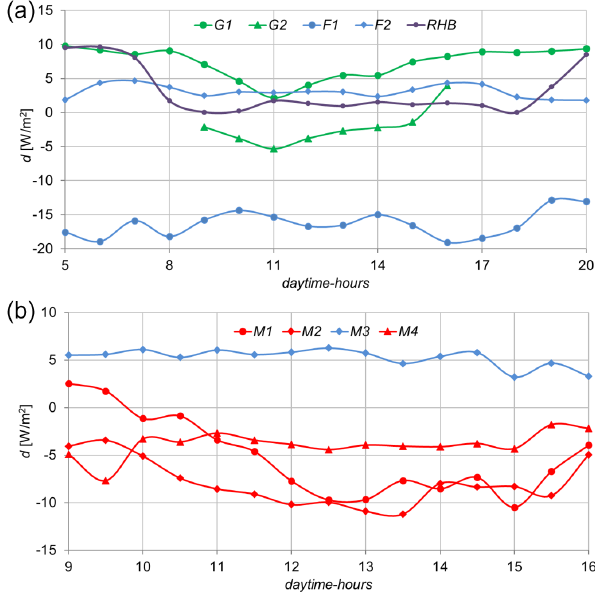
Figure 6. Systematic differences d between LE LY and adjusted LE EC_a : (a) as a function of daytime hours, humid; and (b) as a function of daytime hours, Majadas red: dry season; blue: rainy sea- son.